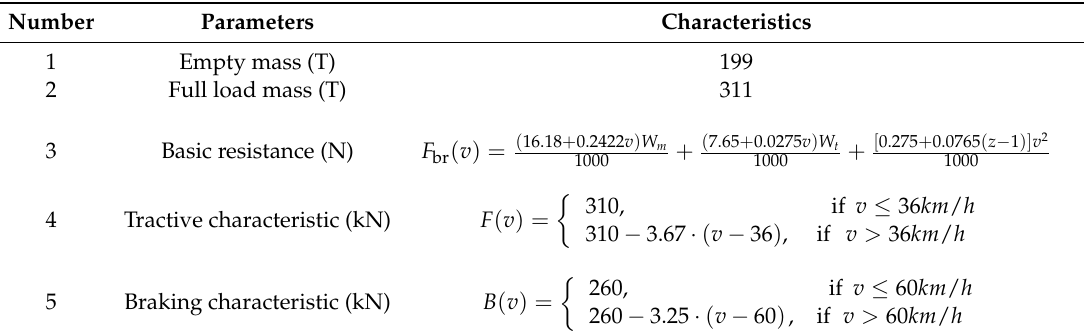
Table 7. Characteristics of the